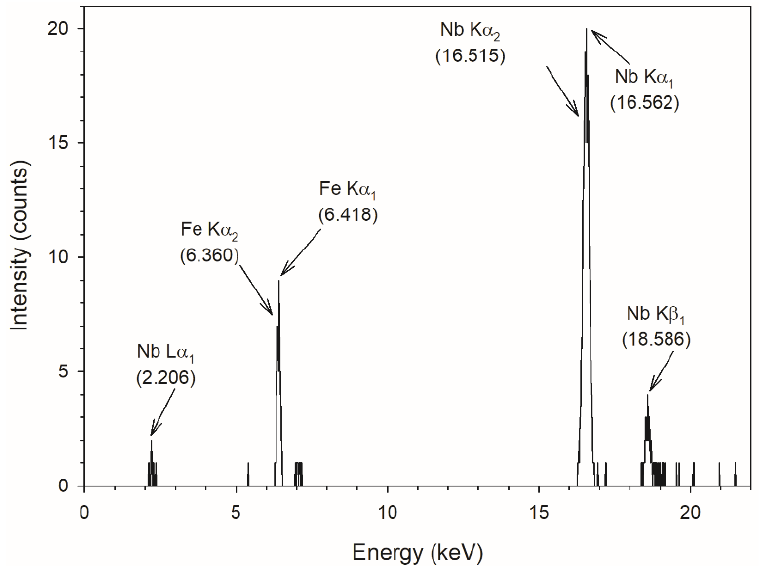
Figure 1. XRF spectrum of the residue present after FID.